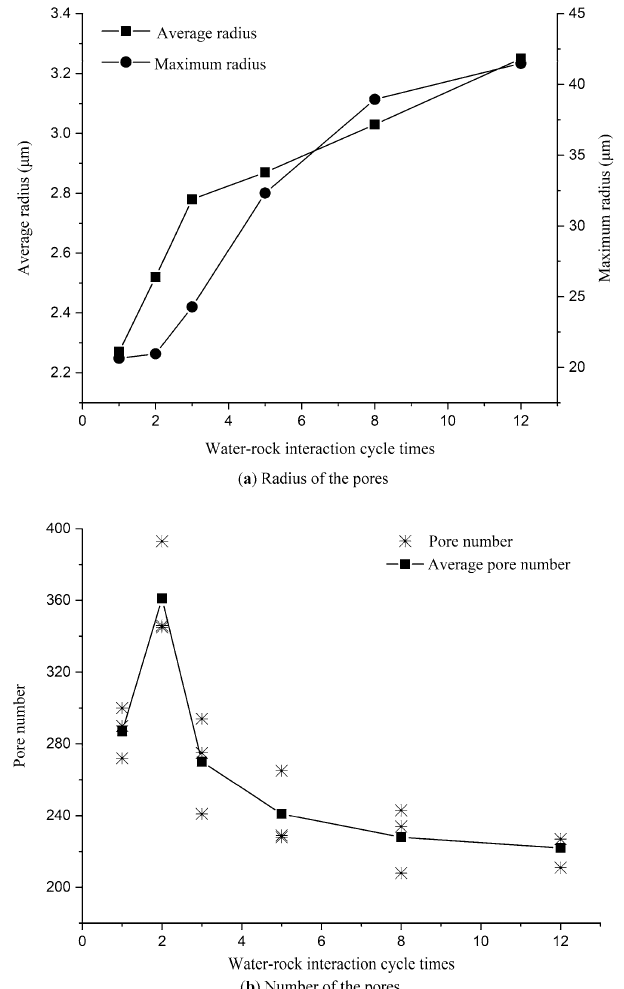
Figure 6. Radius and number variation rules of the pores by water–rock